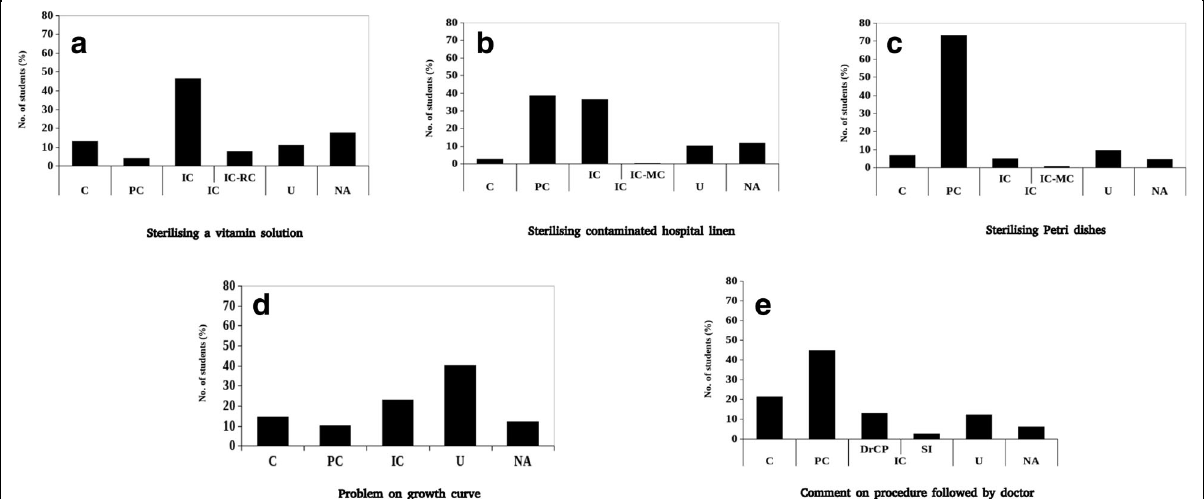
Fig. 1 Percentage of student responses in each category for the three questions identified by their keywords: a – c Subparts of the “ easy ” question, d “ moderate ” question, e “ difficult ” question. The x-axis represents categories of student responses. C Correct; PC Partially Correct; IC Incorrect; IC-RC Incorrect method, correct reason; IC-MC Incorrect reason, correct method; DrCP Doctor followed the correct procedure; SI Soap is an irritant; INC Incomplete; U Unrelated; NA Not